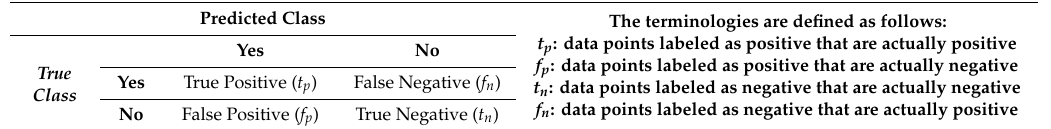
Table 3. Confusion metrics